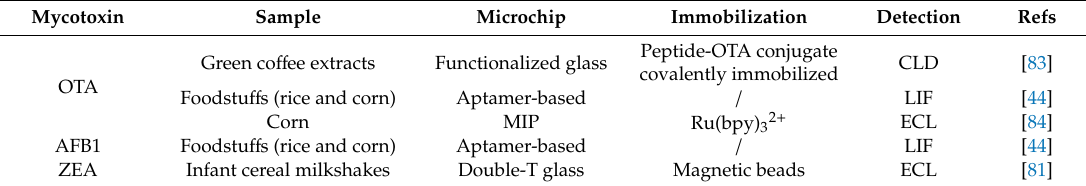
Figure 6. Aptamer-based microchip - CE - LIF in the simultaneous analysis of AFB1 and OTA. ( a ) complex formation procedure; ( b ) microchip platform; ( c ) electropherograms of ( A ) OTA in presence of aptamer-AFB1/C-aptamer; ( B ) AFB1 in presence of aptamer - OTA/C-aptamer and ( C ) simultaneous analysis. (Reproduced with permission from Xiao, Journal of Chromatography A ; published by Elsevier, 2018 [44]). Table 2. Types of mycotoxins analyzed by microchip-CE techniques.